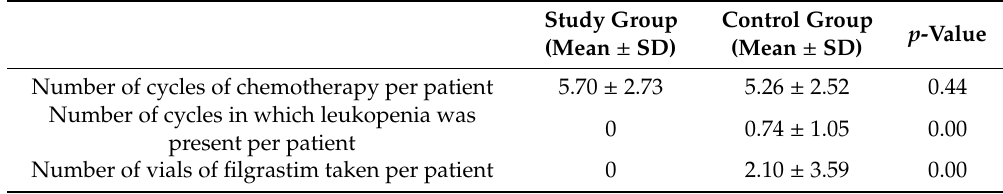
Table 5. Di ff erence between parameters in study and control group. Table 5. Difference between parameters in study and control group.